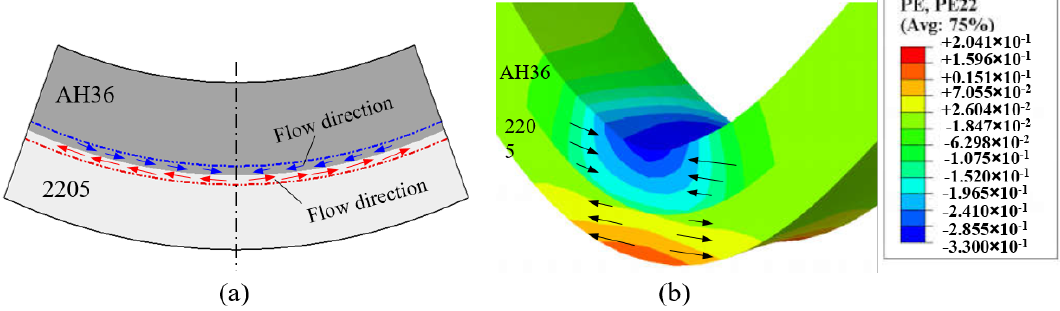
Figure 16. ( a ) The flow directions of different steel layers around the interface during the hot bending process, and ( b ) the distribution of the equivalent plastic strain of the bent specimen along the rolling direction.